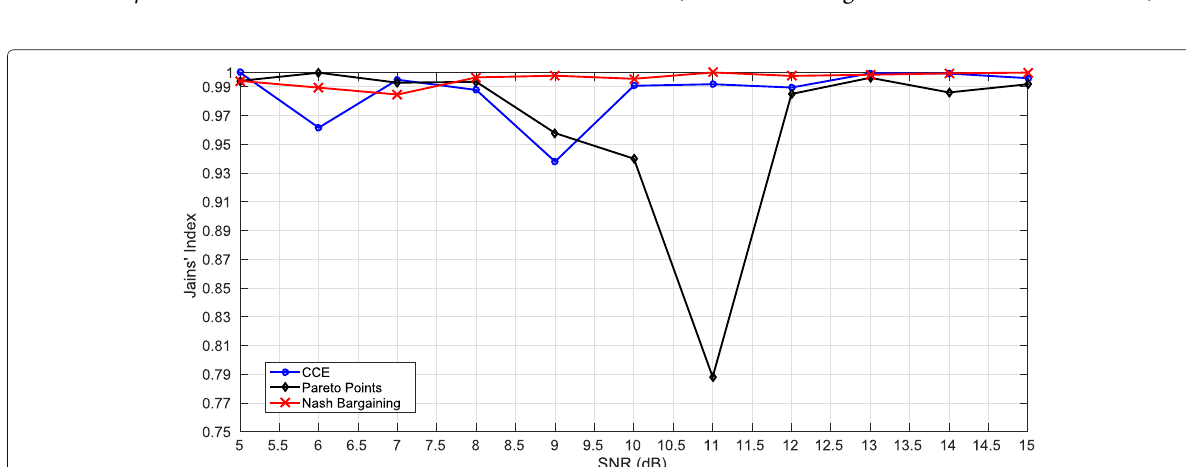
Fig. 9 Comparing fairness of CCE, PP and NBS for F-MAC-WT, with no CSI of Eve (fixed transmission